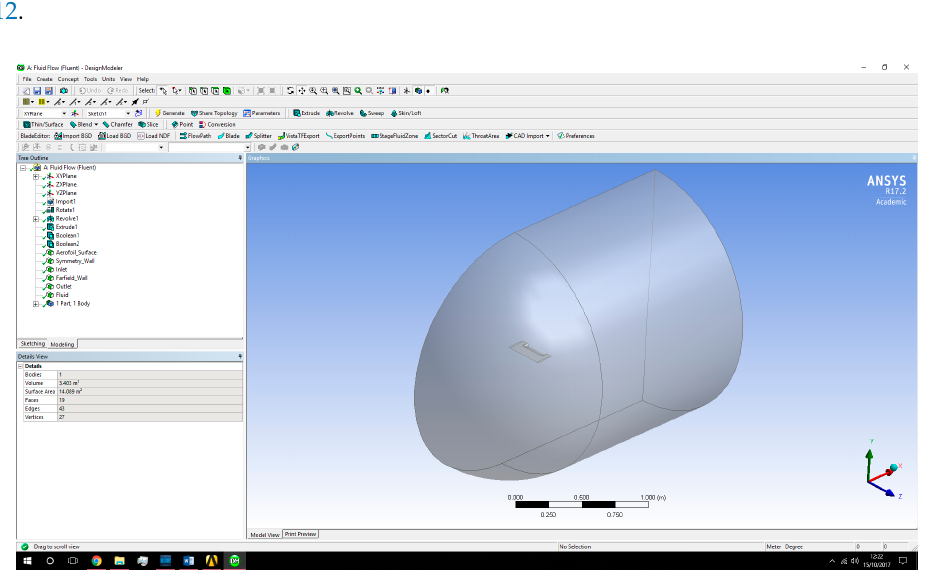
Figure 11. The flow domains geometry.